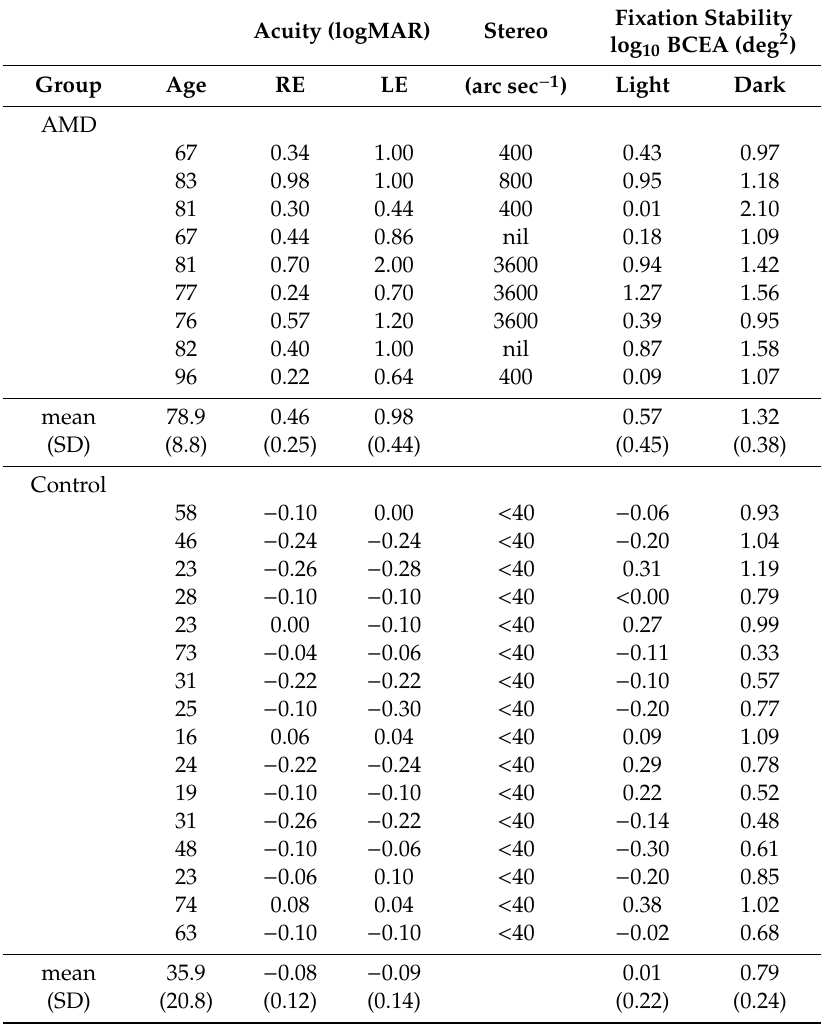
Table 1. Clinical and demographic characteristics of the two